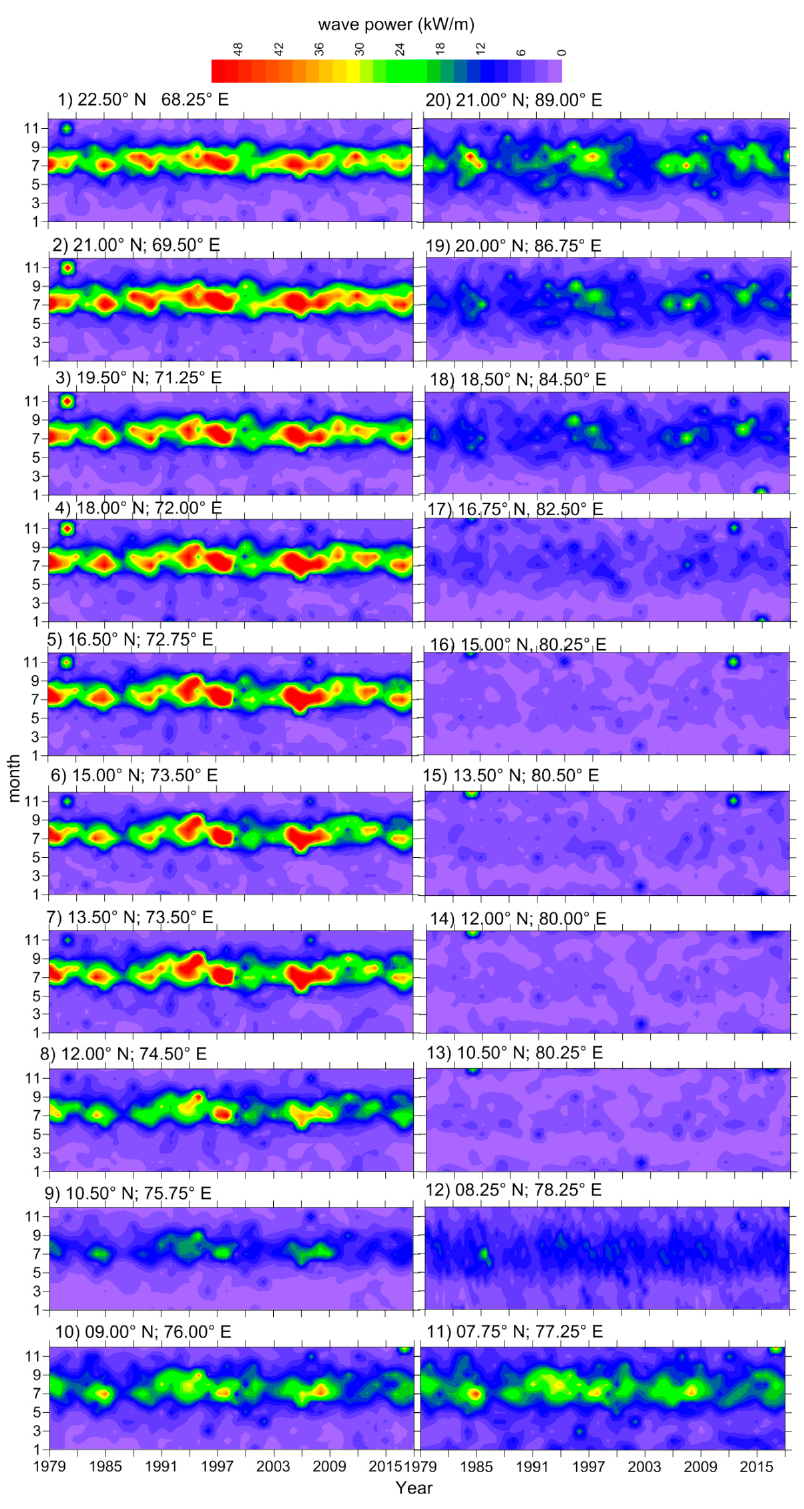
Figure 5. Inter-annual variations in wave power from 1979 to 2018 at 20 locations depicted in month versus year plots.